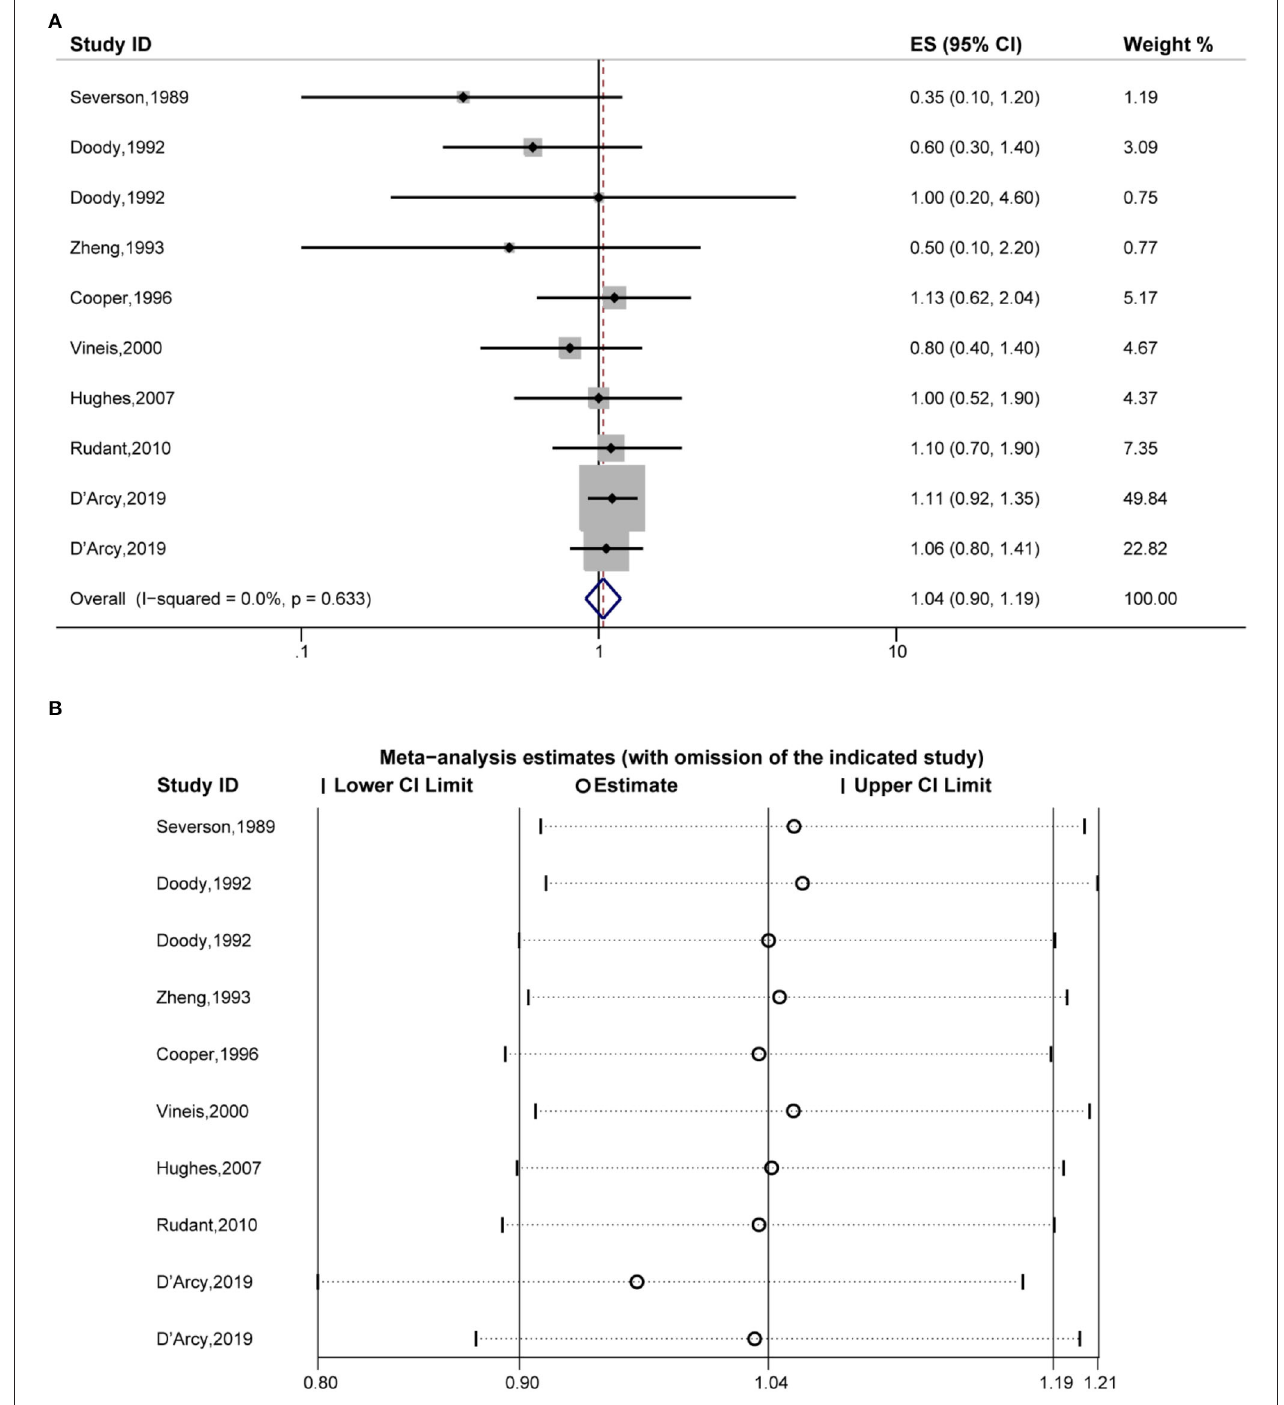
FIGURE 5 | Forest plot of the estimated effects of eczema on myelocytic leukemia risk and the sensitivity analysis. (A) Forest plot of eczema on myelocytic leukemia risk. (B) Sensitivity analysis was conducted by recalculating the pooled results of the primary analysis following the exclusion of one study per iteration.